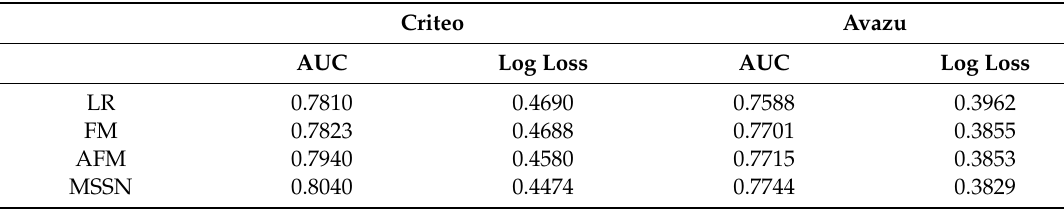
Table 2. Comparison of multi-scale stacking pooling (MSSP) with other models without a deep